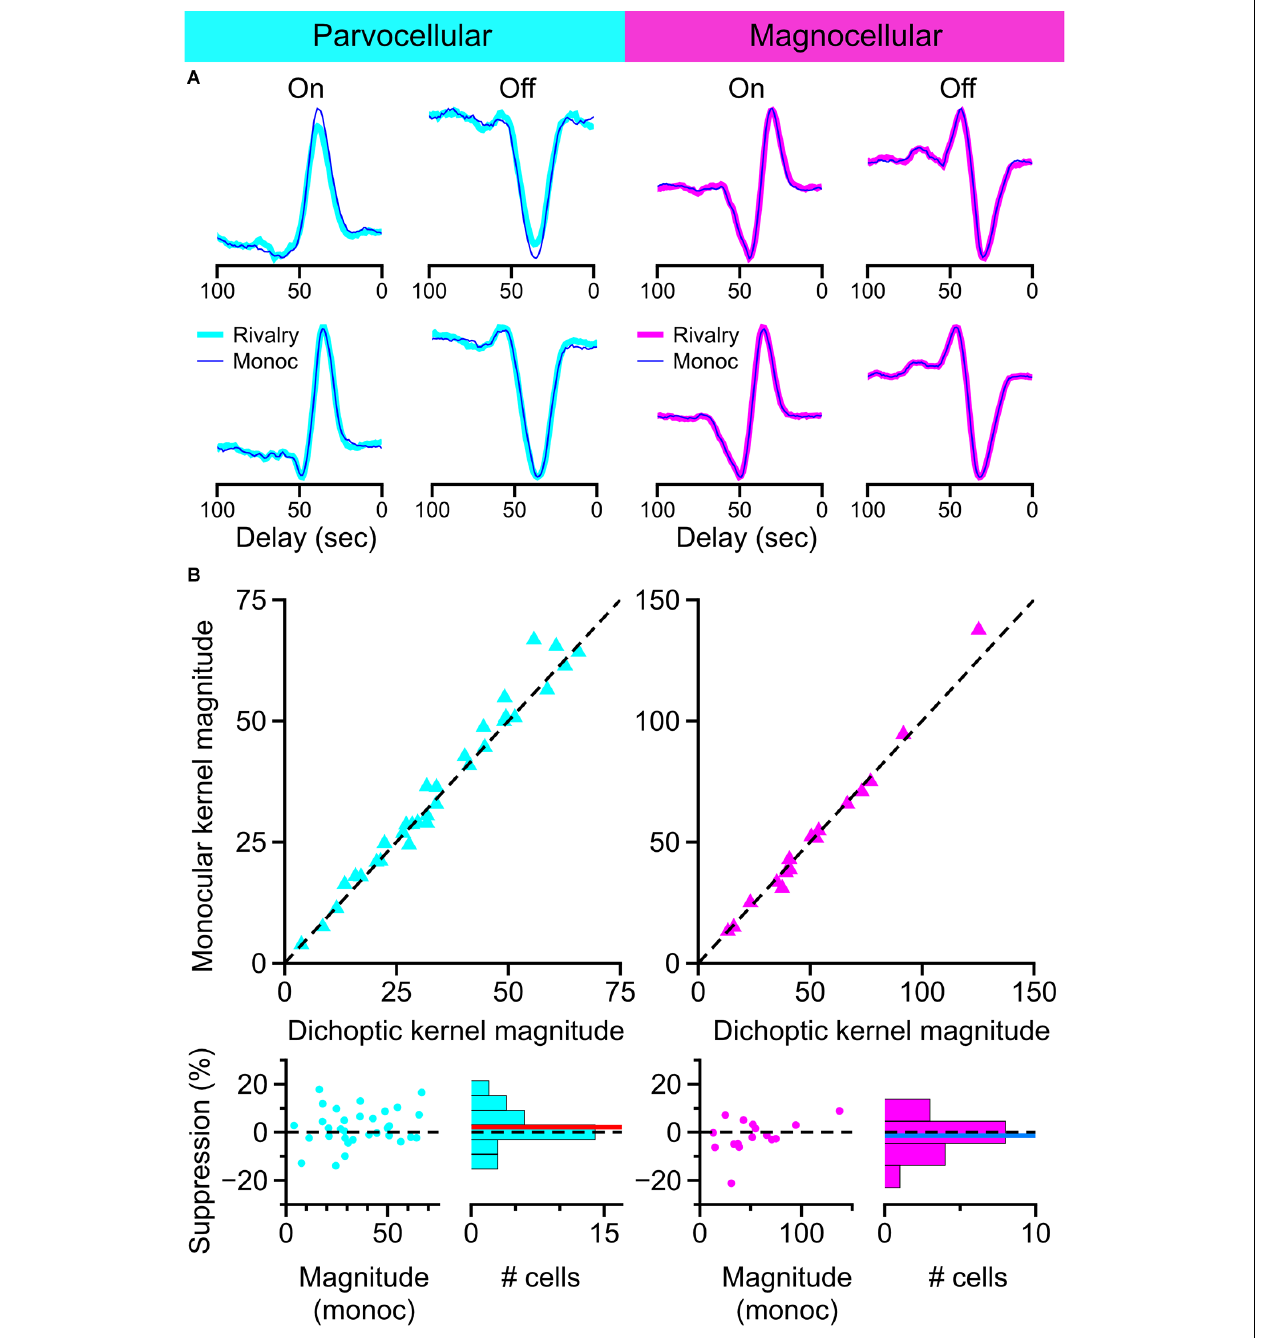
FIGURE 9 | Influence of binocular rivalry on the magnitude of temporal kernels recovered from LGN cells. (A) Example temporal kernels recovered during monocular viewing (thin traces) and during binocular rivalry (thick traces) in parvocellular cells and magnocellular cells. (B) Comparison of kernel magnitudes obtained during monocular viewing and during binocular rivalry. Upper row: scatterplots of the magnitude of kernels recovered during monocular viewing plotted against the magnitude of kernels recovered during binocular rivalry. Lower row: suppression percentage for each cell is plotted against the cell’s monocular kernel magnitude; histogram of suppression percentage for all cells shown at right. Dashed line at 0 for reference, red line, and blue line represent mean suppression.